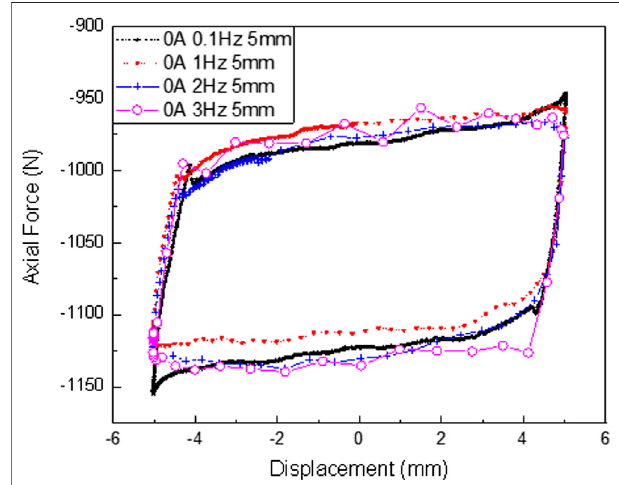
FIGURE 6 | Force-displacement loops with no current applied under different frequencies.